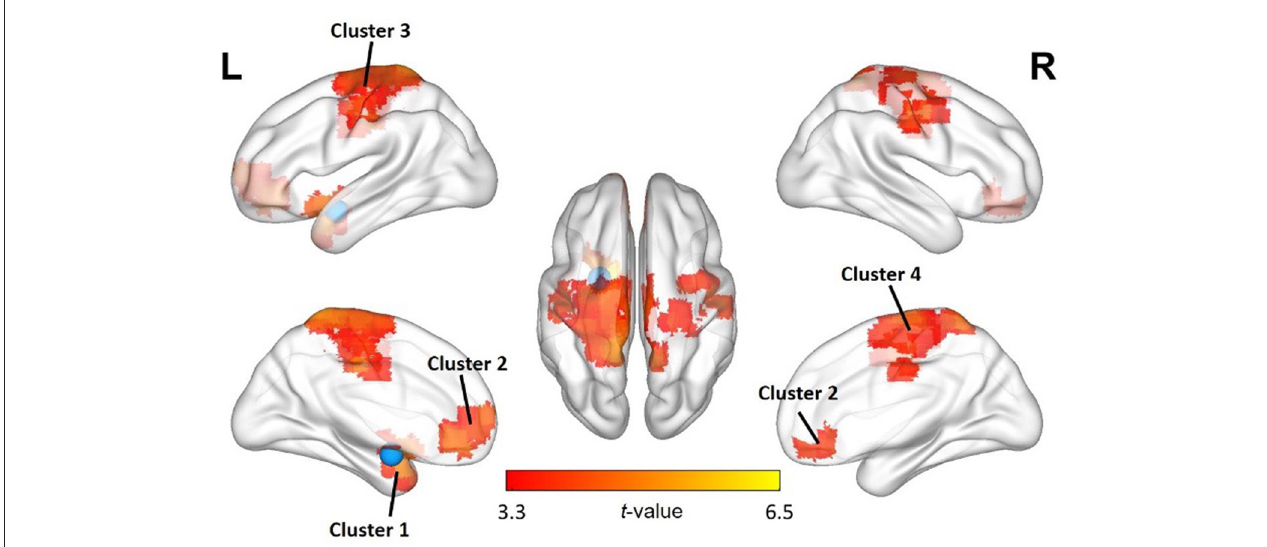
FIGURE 1 | Changes in FC of the left amygdala with other regions after exposure to criticism. A paired sample t -test shows significant FC increases between the left amygdala seed region (blue) and several other brain regions. The significance level was set at p < 0.05 cluster-level FWE correction, with uncorrected voxel-wise p < 0.001 by the cluster-forming threshold. See also Table 4 .